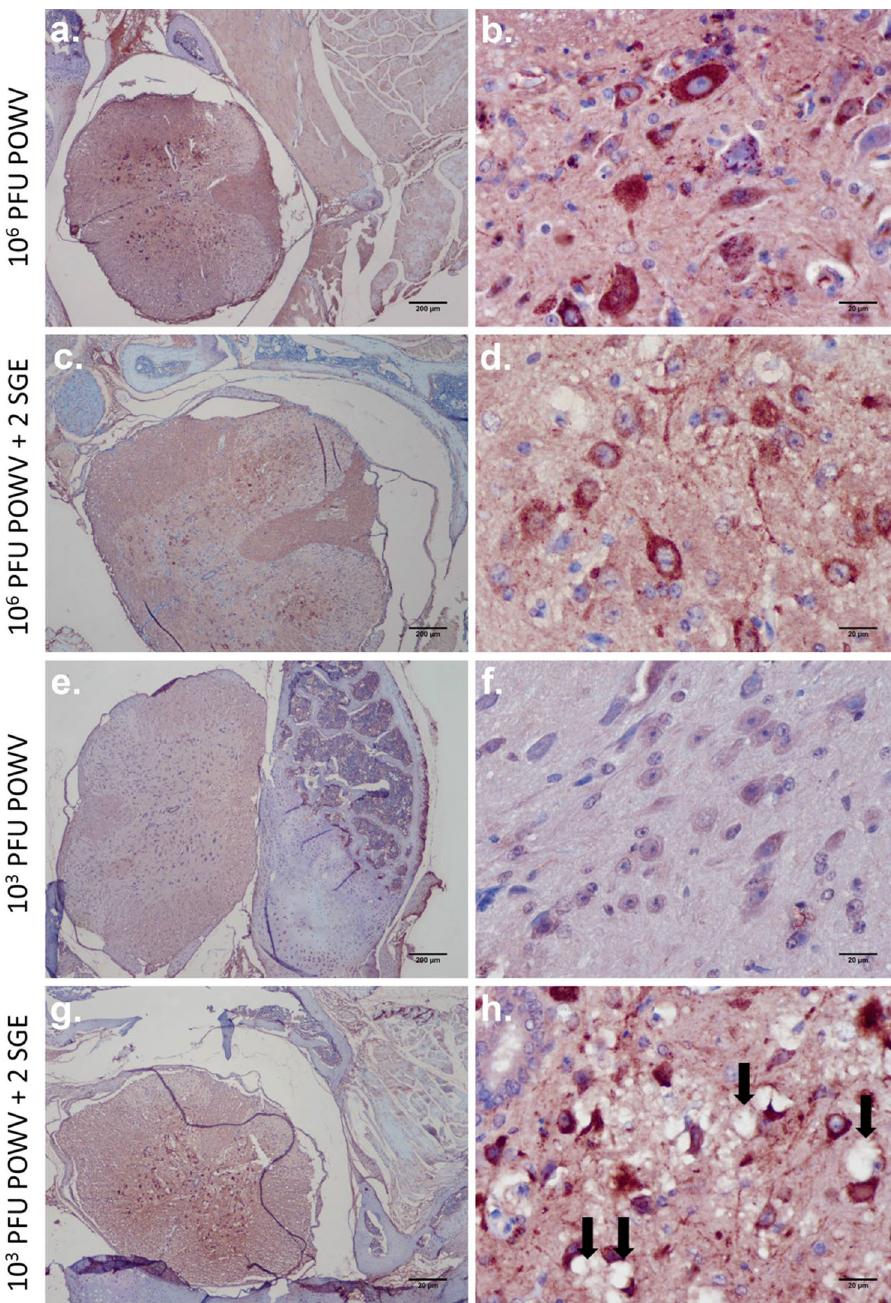
Figure 3. Immunohistochemistry for POWV detection in the spinal cord. ( a , b ) 10 6 PFU POWV. ( c , d ) 10 6 PFU POWV + 2 SGE. ( e , f ) 10 3 PFU POWV. ( g , h ) 10 3 PFU POWV + 2 SGE. Scale bars represent either 200 µm or 20 µm. Black arrows indicate neuropil